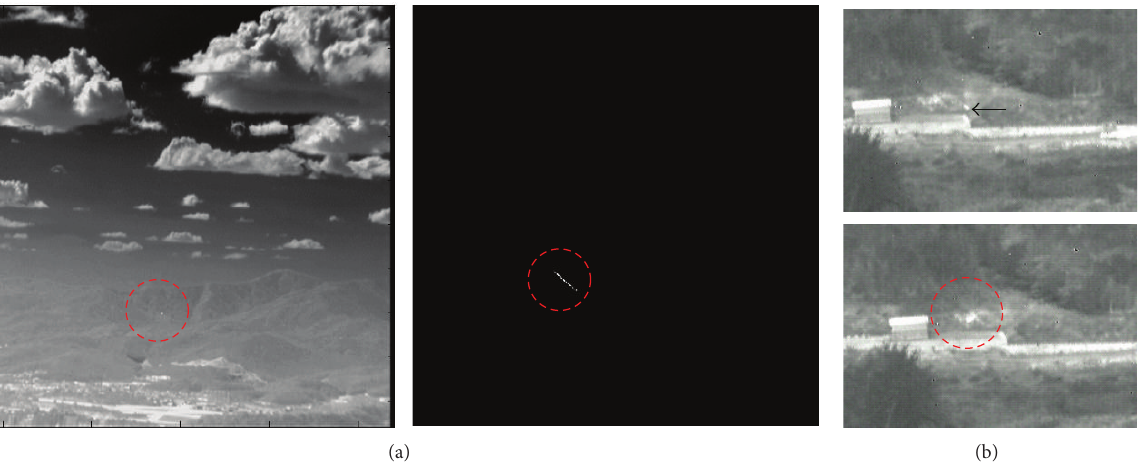
Figure 15: Limitations of TVF-based method: (a) ambiguity of target position and subpixel velocity, (b) target missing by the intersection of TVF and spatial